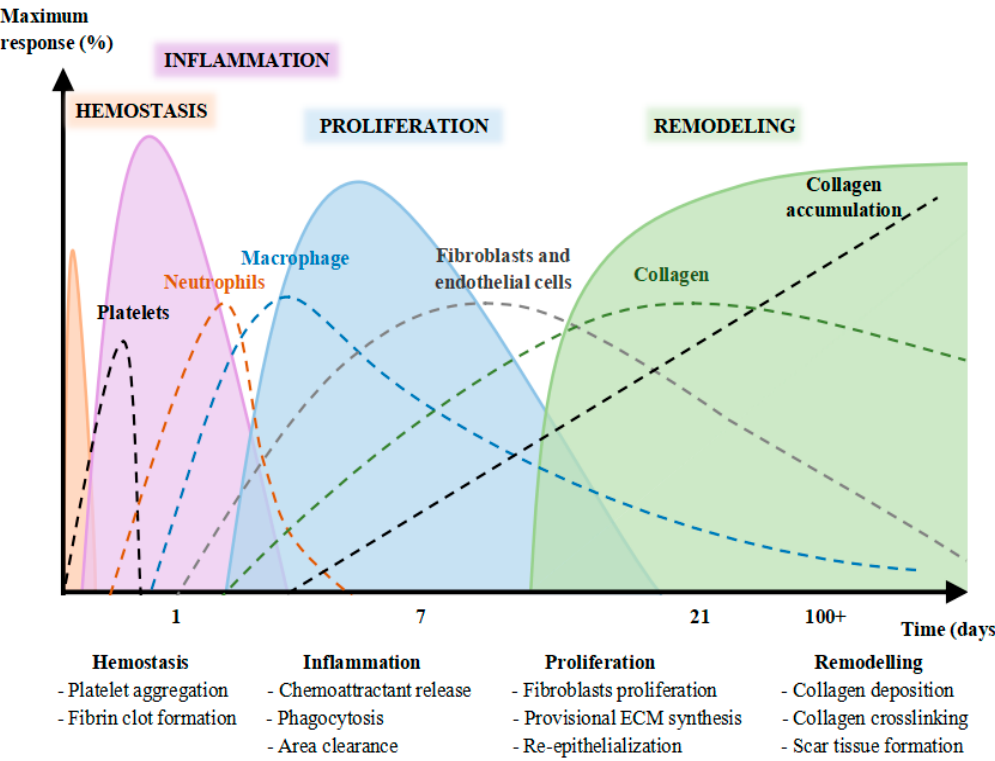
Figure 1. Stages of skin wound healing (haemostasis, inflammation, proliferation, and repair and remodelling) over time. Source: [14].